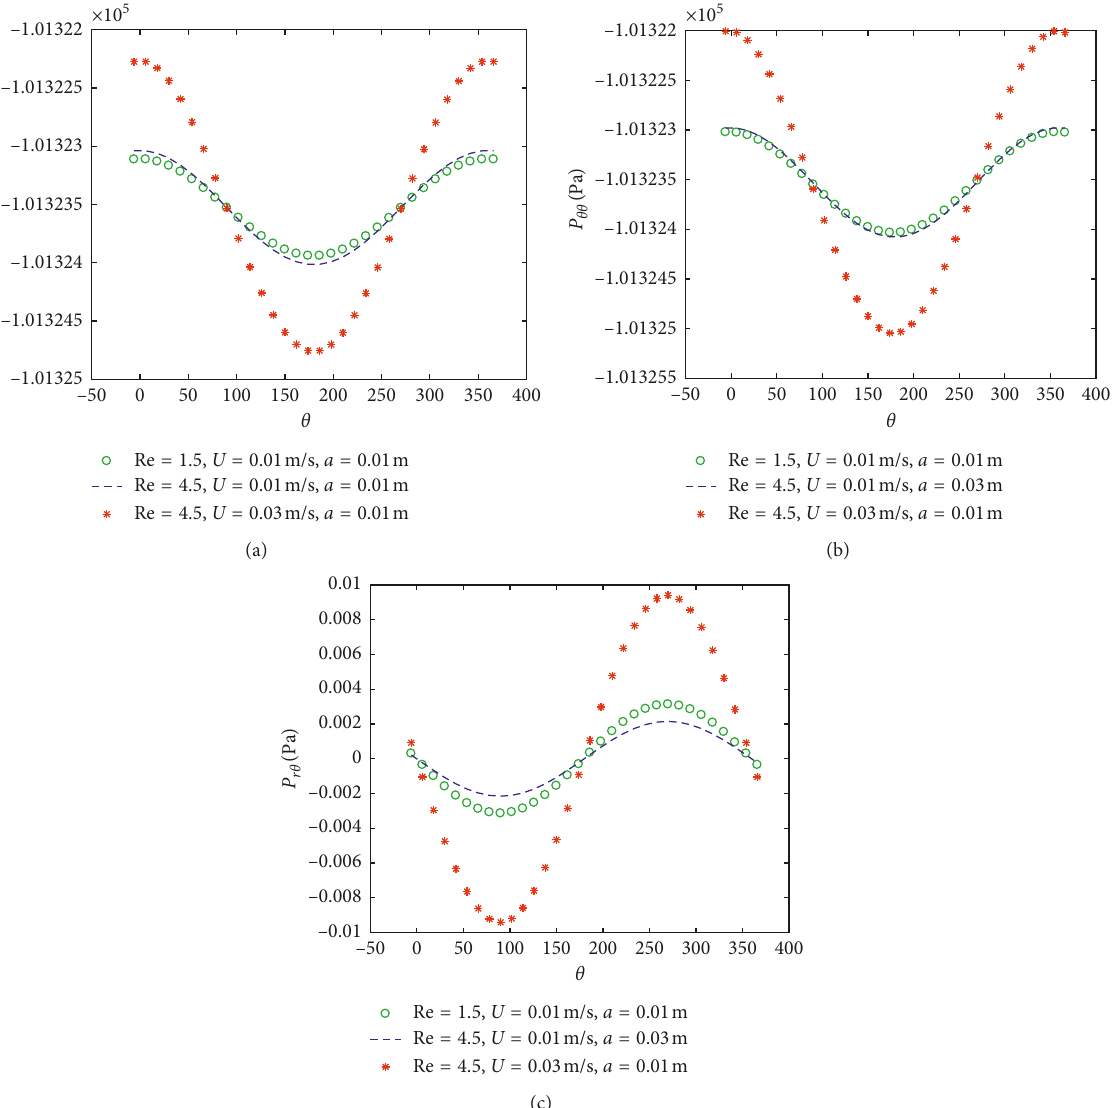
F IGURE 11: Angular distribution of normal stress, due to fluid viscosity under different Reynolds number, at r � 3 . 55 a and t � 350 μ s : (a) radial normal stress, (b) circumferential normal stress, and (c) shear stress P r